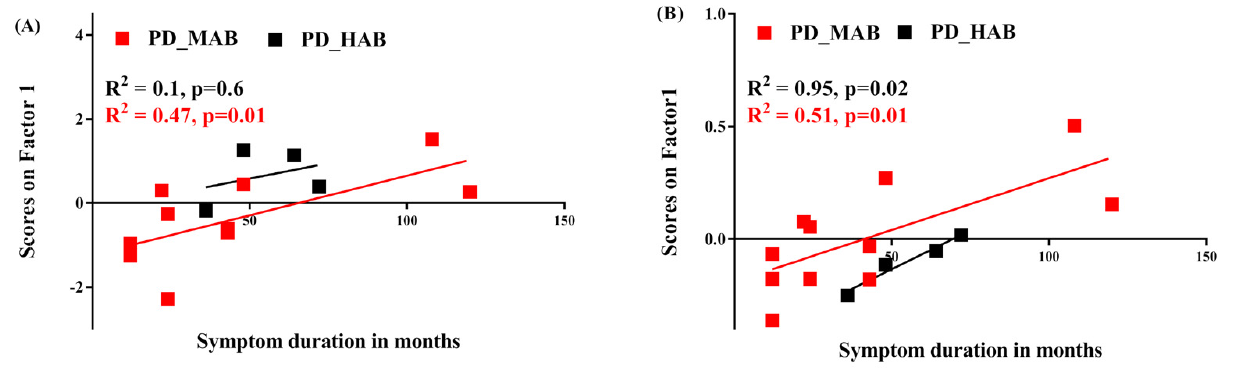
Figure 6. Graphs of scores on principal components. ( A ) Scores on PC1 of absolute SUV PCA decomposition. In mixed affinity binder (MAB) groups: PD and UC groups were not significantly different, whilst PD and HC were at the limit of significance and the UC group was significantly higher than HC. In high-affinity binder (HAB), however, the three groups were not significantly different from HC. ( B ) Scores on PC2 of SRP-SUV PCA decomposition. The three groups were not significantly different from HC in MAB and HAB groups. The asterisks in the plot identify significant differences between groups ( p < 0.05).